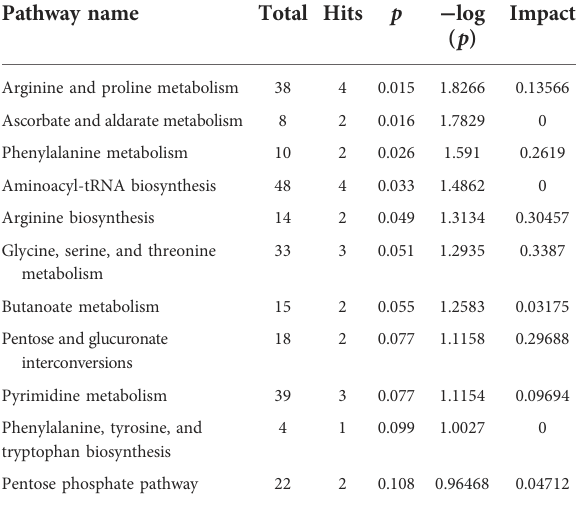
TABLE 2 Pathway analysis for the 46 critical metabolites based on KEGG. Pathway